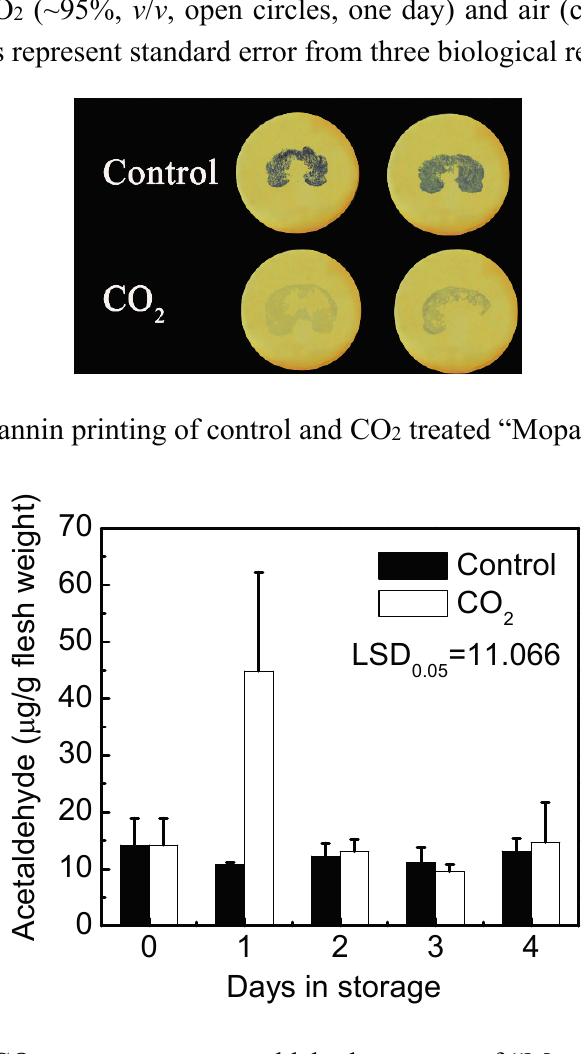
Figure 3. Effect of CO 2 treatment on acetaldehyde content of “Mopan” fruit. Mature fruit were treated with CO 2 (~95%, v / v , white bars, one day) and air (control, black bars), separately at 20 °C. Error bars represent standard error from three biological